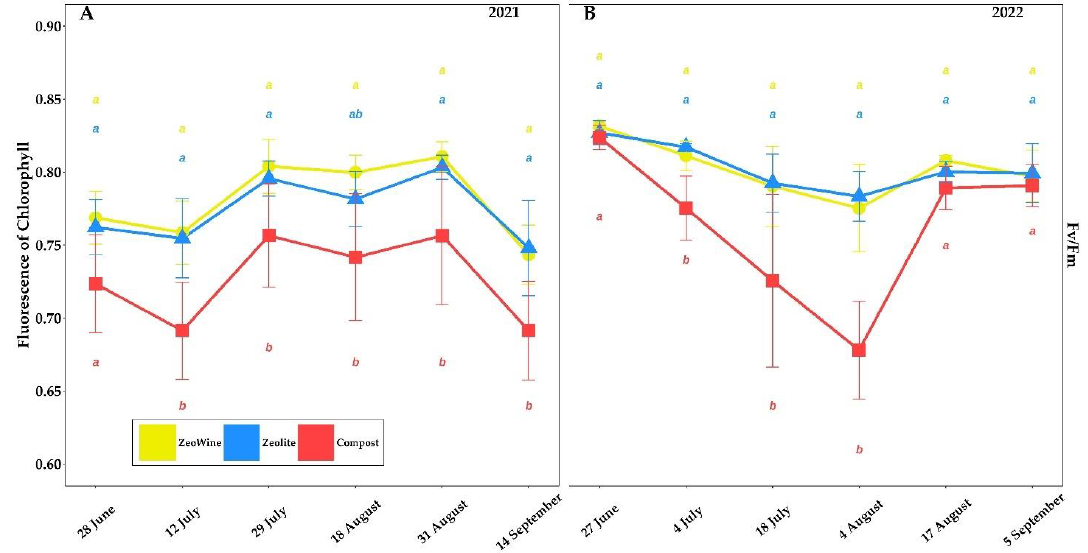
Figure 4. Physiological parameters (ter). Fluorescence of chlorophyll (Fv/Fm) of Vitis vinifera with three different soil management treatments. Measurements were conducted from June to September (2021 and 2022, ( A , B )). Data (mean ± SE, n = 10) were subjected to one-way ANOVA. The bars represent the standard deviation. Different letters indicate significant differences between Zeowine, Zeolite, and Compost (LSD test, p ≤ 0.05).